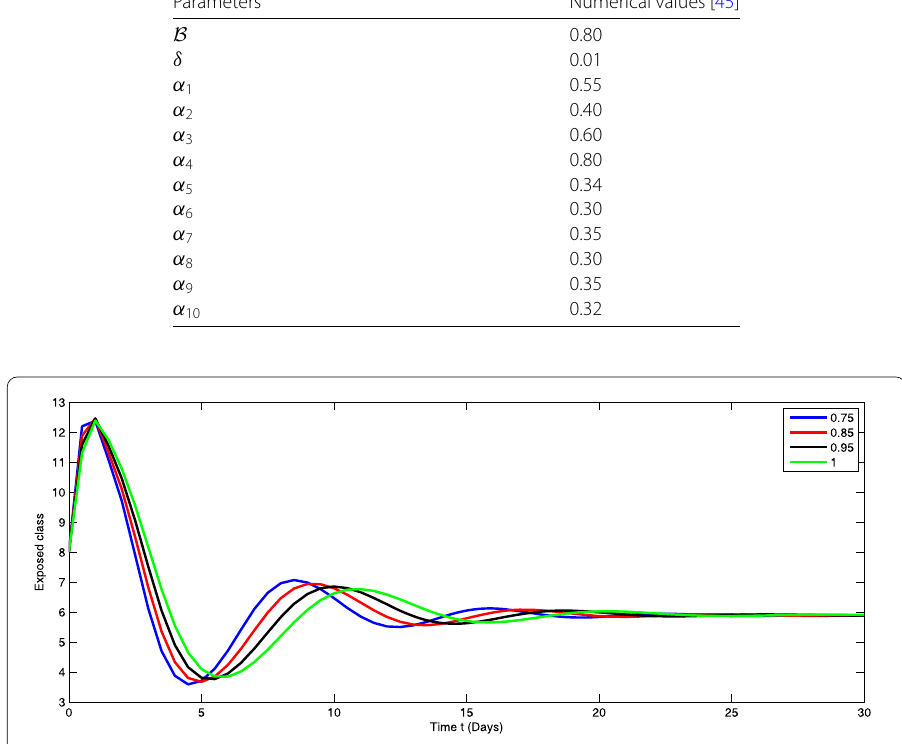
Figure 1 Graphical representation of the approximate solution E for the first ten terms at different fractional